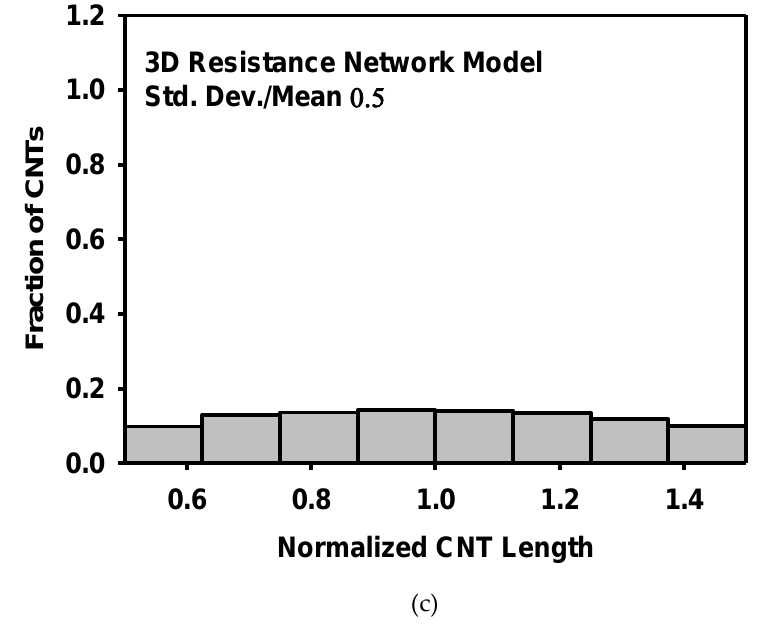
Figure 20. Three distributions of the CNT lengths used in the 3D resistance network model with the ratio of standard deviation to mean CNT length of ( a ) 0, ( b ) 0.25, and ( c ) 0.5.